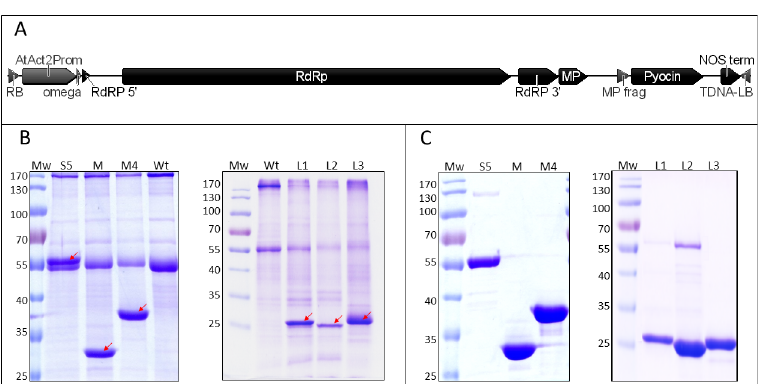
Fig 1. Pyocin expression in plants. A–schematic presentation of T-DNA region with pyocin expression cassette. RB–right T-DNA border, AtAct23Prom– A . thaliana actin promoter, RdRp–RNA- dependent RNA polymerase, MP–truncated TMV movement protein, LB–left T-DNA border. B–expression of pyocins in N . benthamiana leaves. Plant material(50 mg) was harvestedat 5 or 7 days post spraying (dps) (pooledsamples of three leaves—pyocins S5, PaeM, PaeM4, L1, L2 at 5 dps, L3 at 7 dps), groundin liquidnitrogen, extracted with 50 mM Tris-HCl, 150 mM NaCl (pH 7.0) (S5, PaeM and PaeM4) or 50